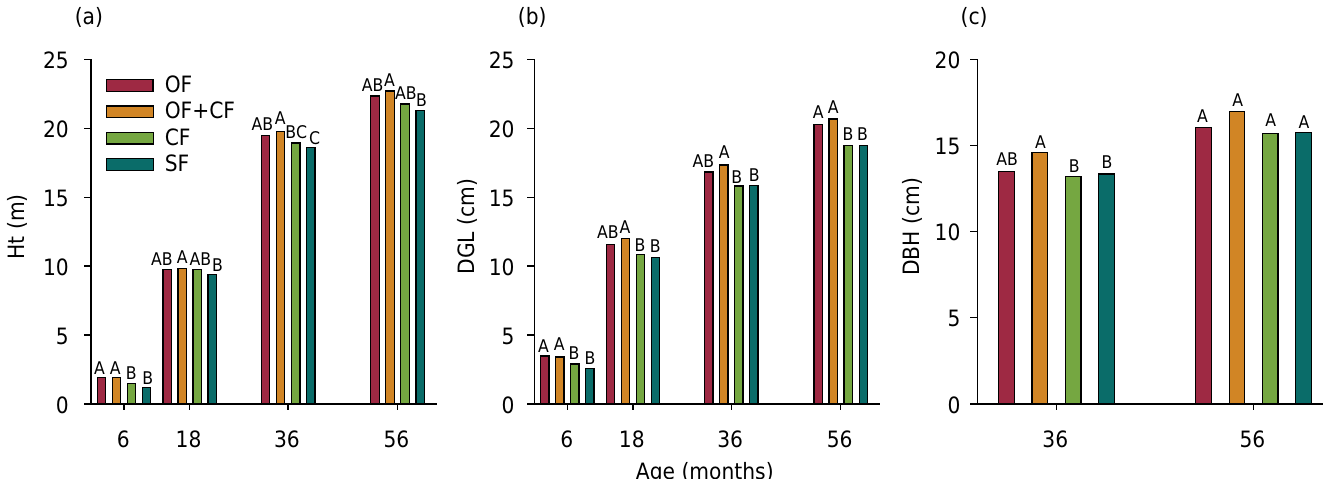
Figure 2. Total growth in height (Ht; a); diameter at ground level (DGL; b); trunk diameter at breast height (DBH; c) in Eucalyptus (Euc) from planting to 6, 18, 36, and 56 months of age, submitted to organic (OF), combined organic and chemical (OF+CF), chemical (CF), and standard (SF) fertilizers, planted in an area of bauxite mining. Uppercase letters compare fertilization treatments within the same age and, when equal, indicate no differences between them by the Tukey’s test at 10 % probability